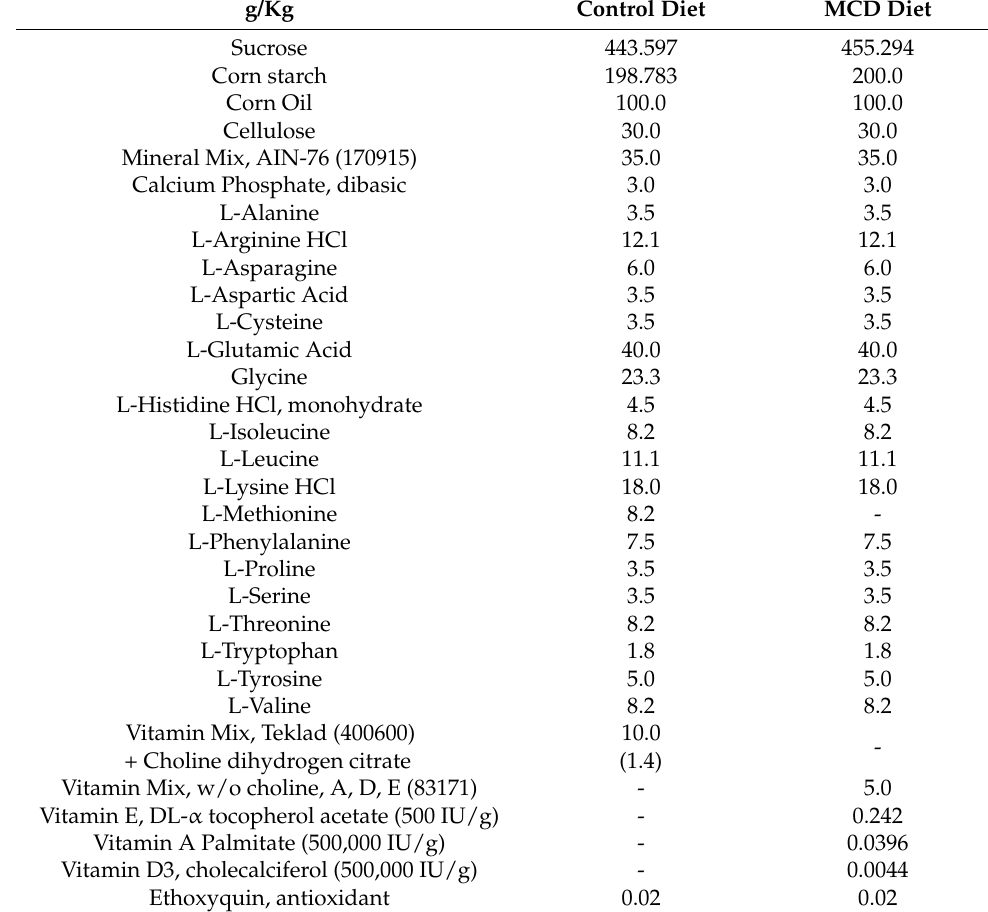
Table 2. Elemental composition of MCD and control